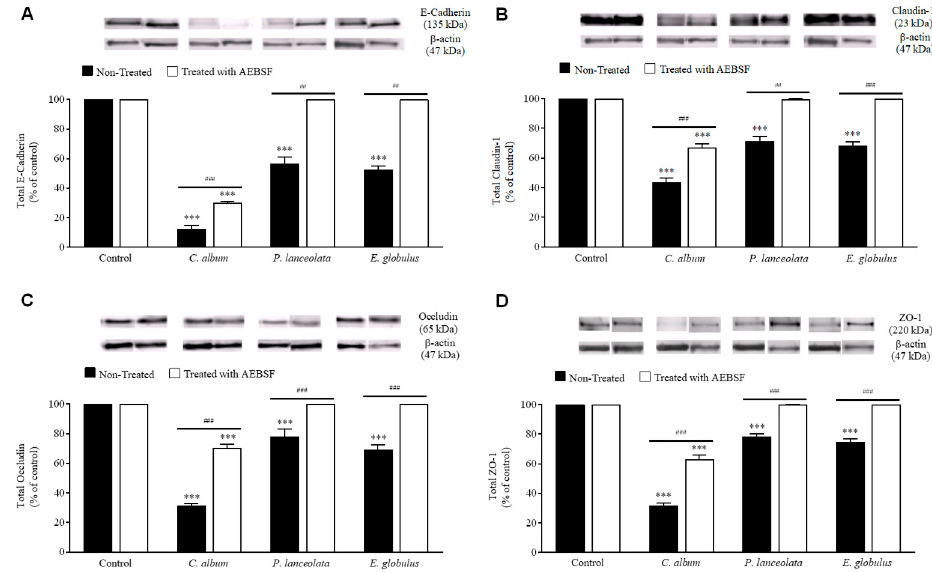
Figure 3. Effect of pollen diffusates on intercellular junction integrity. Calu-3 cells were exposed to pollen diffusates from Chenopodium album (0.26 ± 0.06 mg/ml), Plantago lanceolata (0.18 ± 0.03 mg/ml) and Eucalyptus globulus (0.75 ± 0.18 mg/ml) (black bars) for 6 h. The cells were also incubated with pollen diffusates that were pre-treated with 1 mM AEBSF (white bars). The degradation of the transmembrane proteins E-cadherin (A) claudin-1 (B) occludin (C) and the cytosolic complex ZO-1 (D) was analyzed by immunoblotting. Cells incubated with culture medium were used as a control. The data were normalized and expressed as a percentage relative to each control. Representative blots are shown for each stimulus. Bonferroni post-test: *** p < 0.001 ( n = 5) in comparison to the control condition, and ### p < 0.001; ## p < 0.01 ( n = 5) for comparisons between treated and untreated conditions.